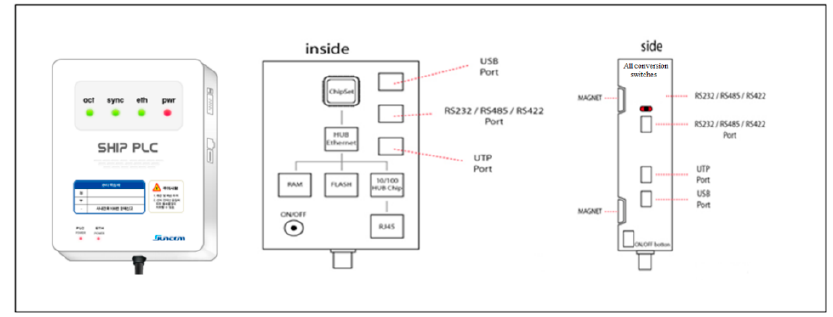
Figure 14. Diagram of the PLC slave modem.